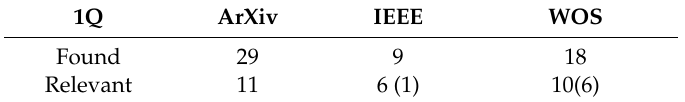
Table 1. Results from the search after “Techniques image caption generation” search query.